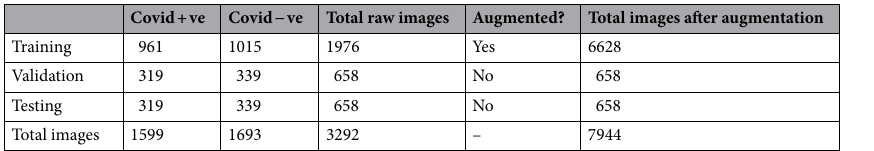
Table 3. Detailed experimental data distribution after augmentation.